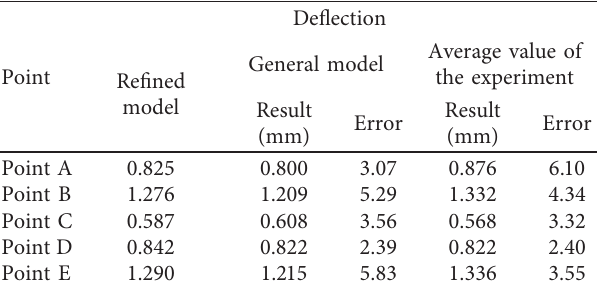
Figure 29: Comparison of the stresses between the experiment and FE models. Table 5: Comparison of the deflections between the experiment and refined FE